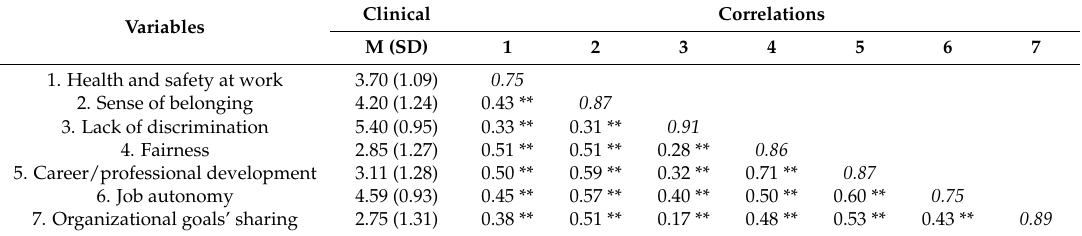
Table 2. Means, standard deviations, and correlations for the clinical staff sample. Clinical Variables